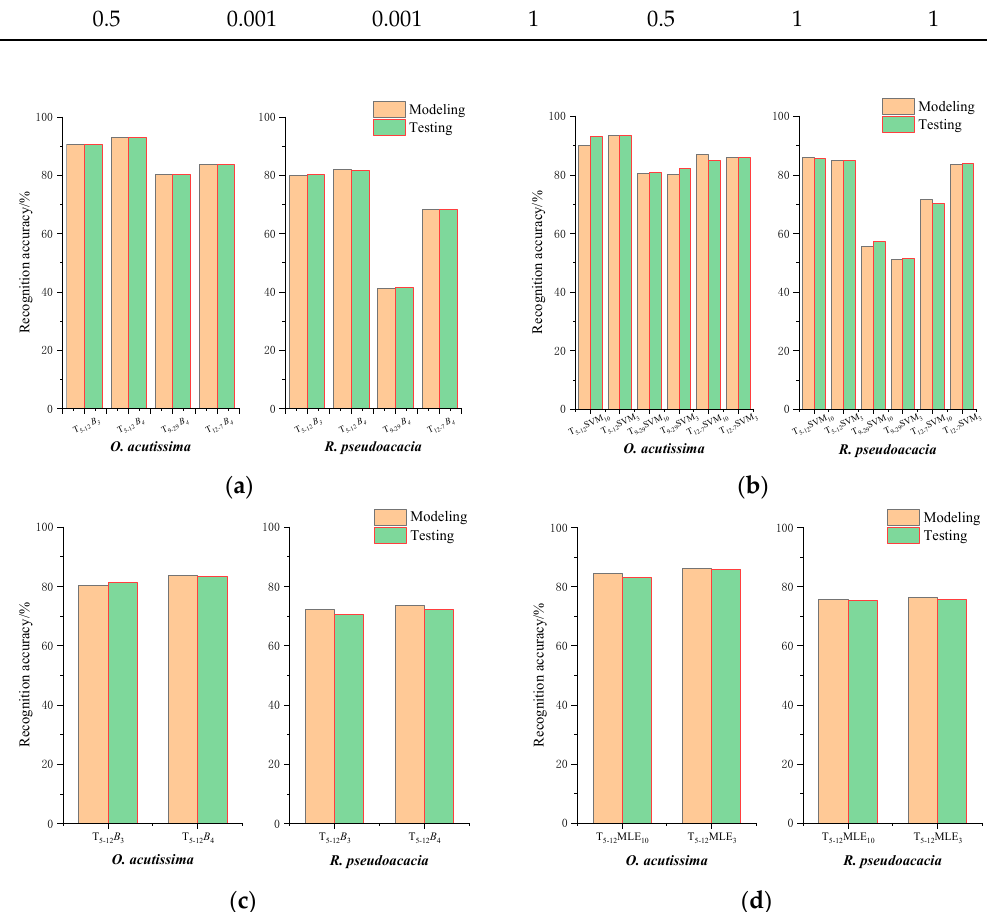
Figure 4. Recognition accuracy of SVM and MLE for O. acutissima and R. pseudoacacia in different phenological phases. ( a ) SVM with sensitive band; ( b ) SVM with sensitive spectral indices. SVM 3 and SVM 10 represent three and ten dimensional SVM models constructed by three best sensitive spectral indices and ten sensitive spectral indices, respectively; ( c ) MLE with sensitive band; ( d ) MLE with sensitive spectral indices. MLE 3 and MLE 10 represent three and ten dimensional MLE models constructed by three best sensitive spectral indices and ten sensitive spectral indices, respectively.